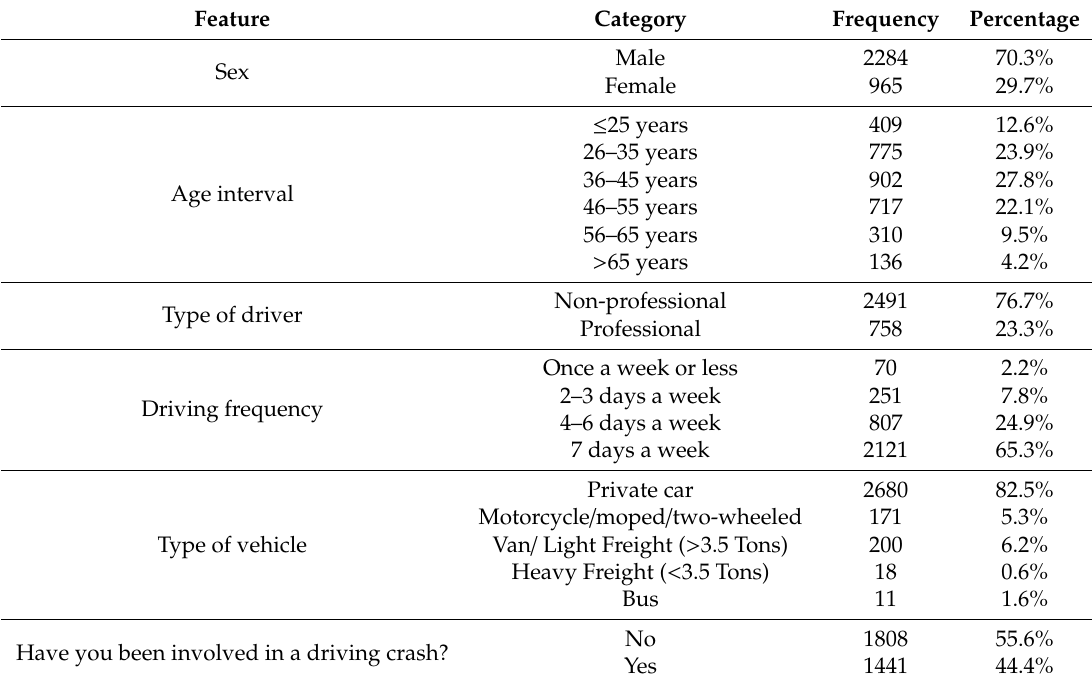
Table 1. Characteristics of the sample used in the